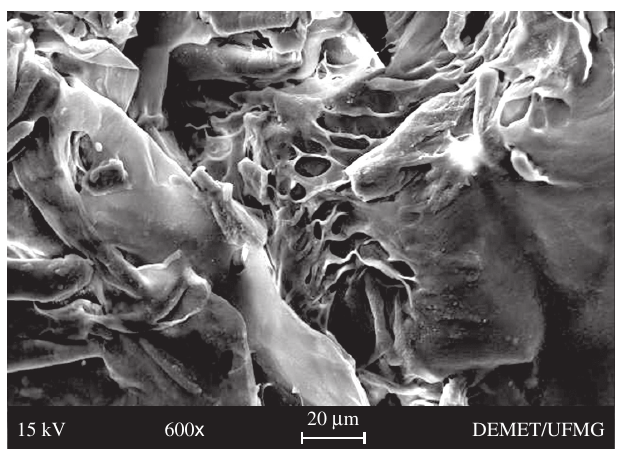
Figure 3. SEM photomicrograph of the amorphous structure of COL showing the presence of fibers and pores.